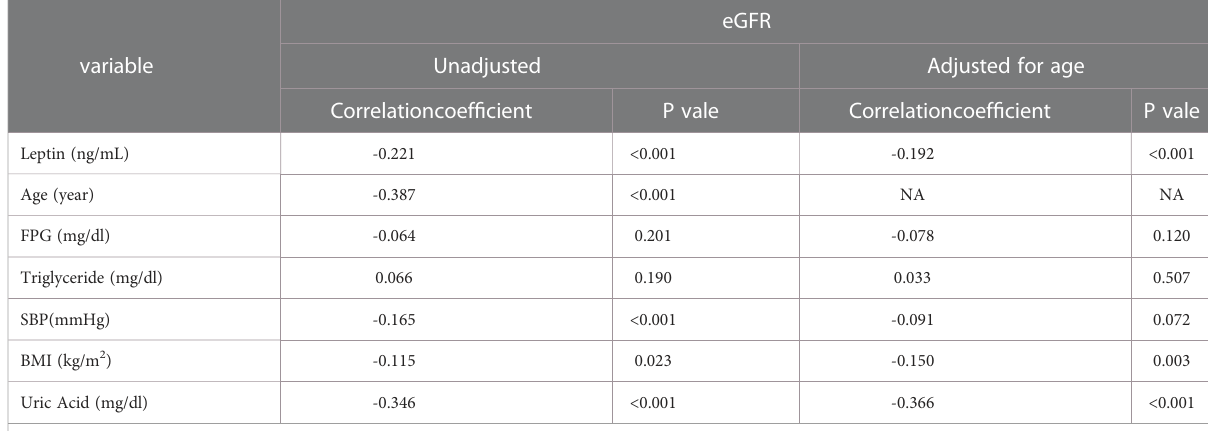
TABLE 2 The Pearson ’ s Correlation between eGFR and serum leptin